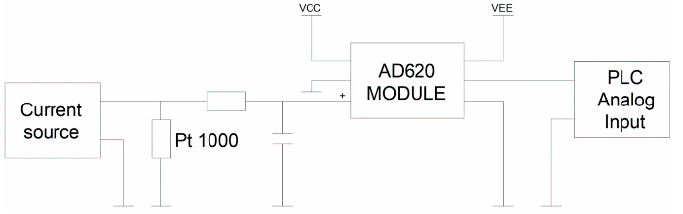
Figure 7. Diagram of the processing path of the temperature measurement system.